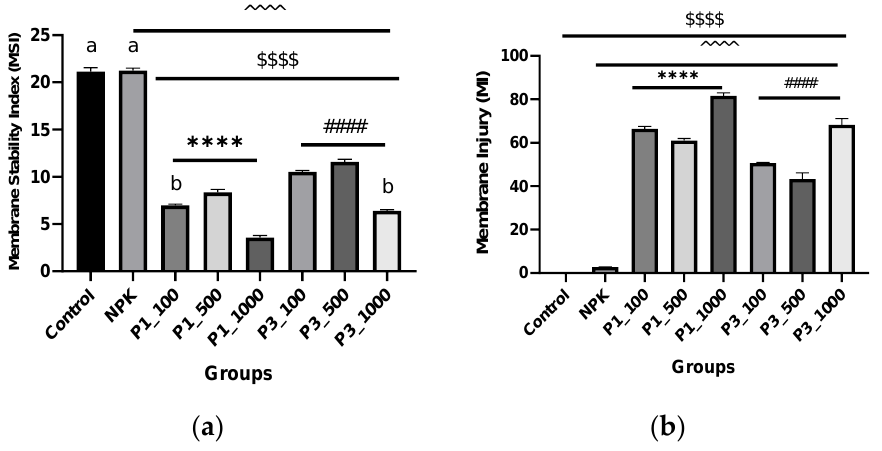
Figure 9. ( a ) Membrane stability index (MSI) and ( b ) membrane injury (MI) in different nHAPs- treated plants. Results are expressed as mean ± SE, $ (dollar sign) significant difference with negative control at p < 0.0001, # (number sign) statistically compared P3 groups with the P3_100. ˆ (circumflex accent) statistically compared with NPK. Different letters refer to the statistically significant difference between groups at p ≤ 0.001, while the same letters refer to non-significant (ns) difference between groups at p ≤ 0.05, using one-way ANOVA followed by Tukey’s test. **** indicates p ≤ 0.0001, (that was applied to the other signs). P1 = nHAP_PPE, P3 = nHAP_CE.